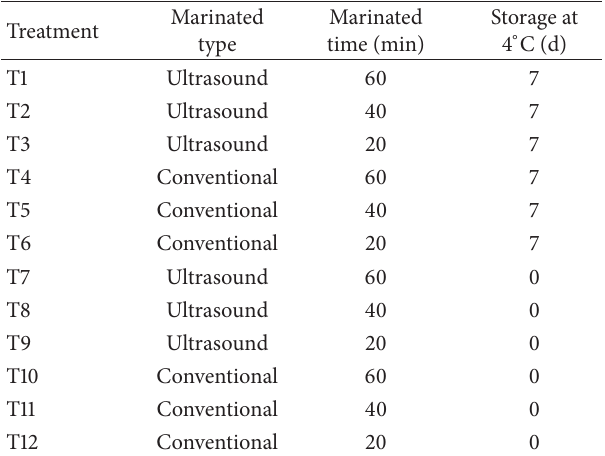
Table 1: Description of treatments. Treatment